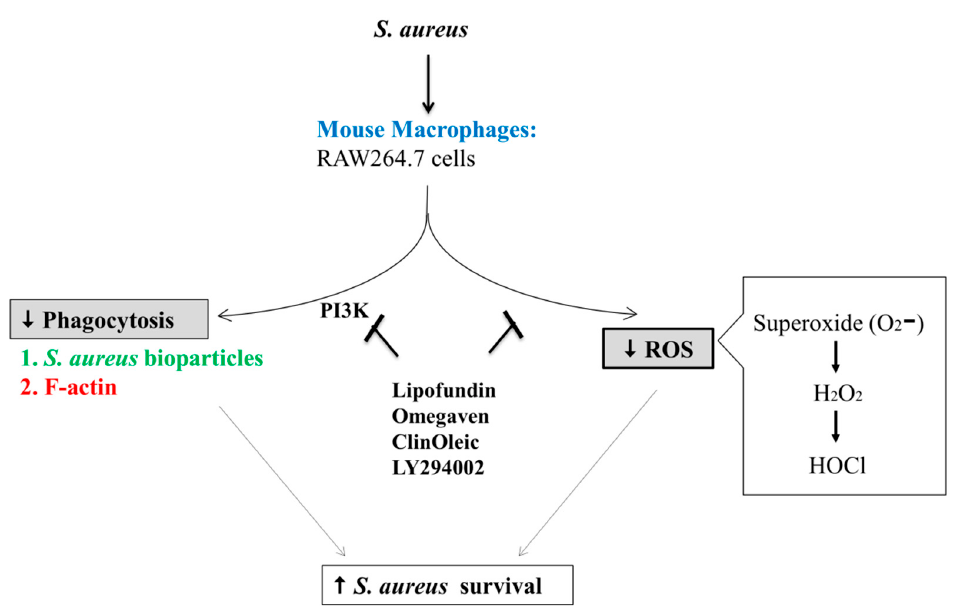
Figure 6. The in vitro inhibition model of lipid emulsions on S. aureus -infected mouse RAW264.7 macrophages. The three lipid emulsions increased S. aureus survival through the suppression of ROS and phagocytosis. Treatment with PI3K inhibitor (LY294002) reduced F-actin reorganization and phagocytosis, which supports the three lipid emulsion-mediated inhibition